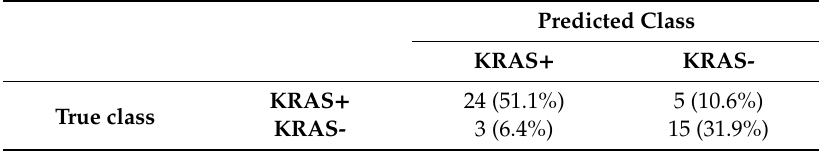
Table 4. Confusion matrix achieved with the texture descriptors and classifier that yielded the highest kappa (i.e., texture vector WCF 15 and classifier NNET). The percentage is shown in